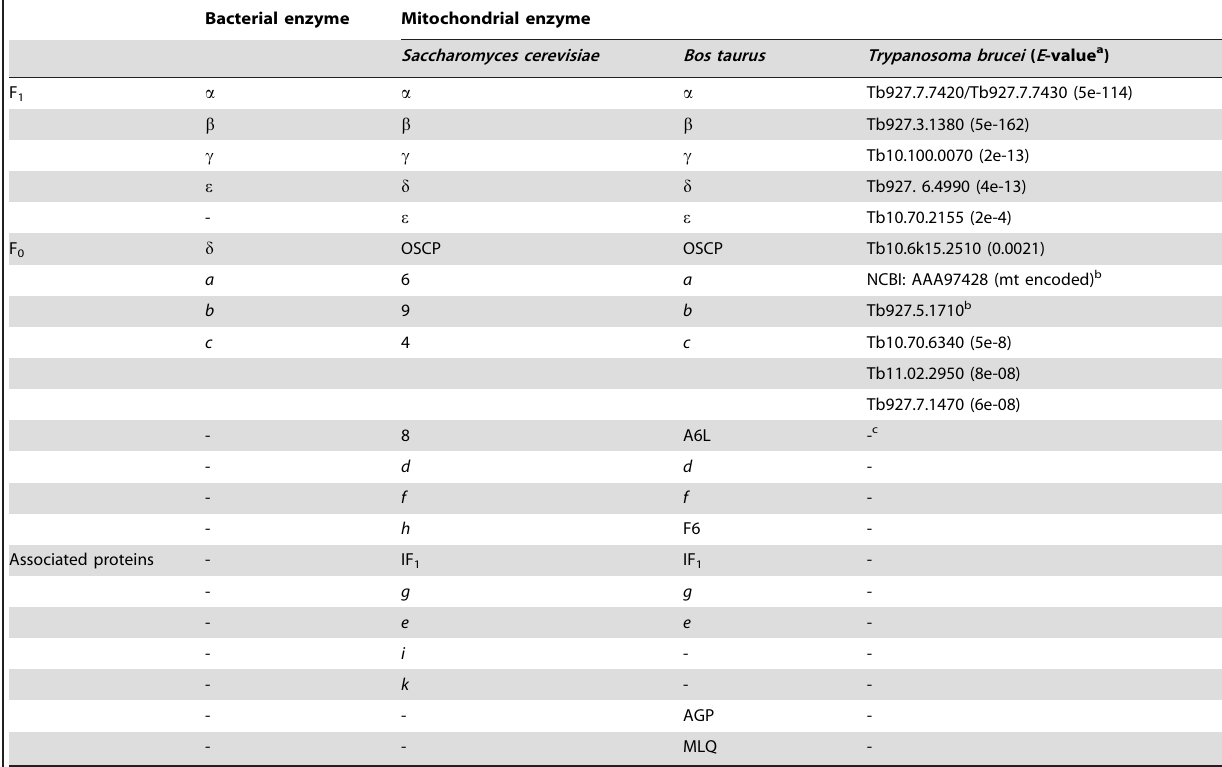
a E -values were obtained by BLAST search analysis using bovine ATP synthase subunits as subject. b T. brucei homologues of subunits a and b are not recognizable by BLAST search and their homology to eukaryotic and bacterial ATP synthase subunits a and b , respectively, was recognized previously by detailed sequence analysis and hydropathic profiles [36,37]. c dash indicates that no homologous proteins were identified in the T. brucei genome using BLAST